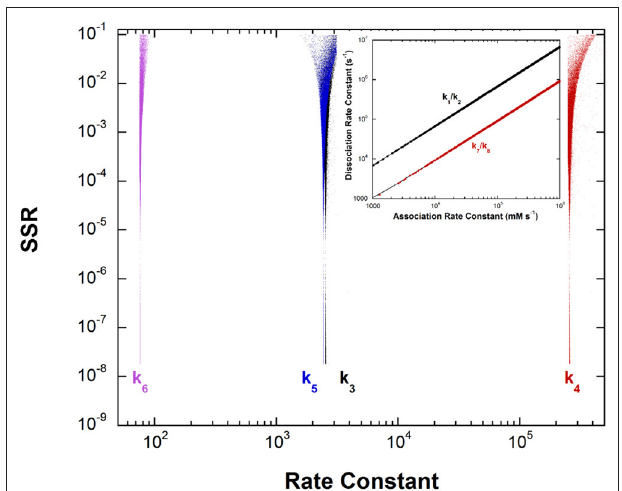
FIGURE 5 | Results of global optimization for the L-Ala/pyruvate half-reaction of dialkylglycine decarboxylase. SSR, sum of squared residuals of the fit to the target function. The figure was generated from ∼ 40,000 independent runs, each starting from randomized sets of rate constants. The inset shows the ratios of the association and dissociation rate constants for both L-Ala and pyruvate binding. The linear correlation over a very large range of values indicates rapid equilibrium binding of